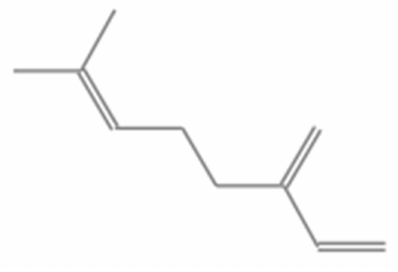
Figure 4. Chemical structure of myrcene.